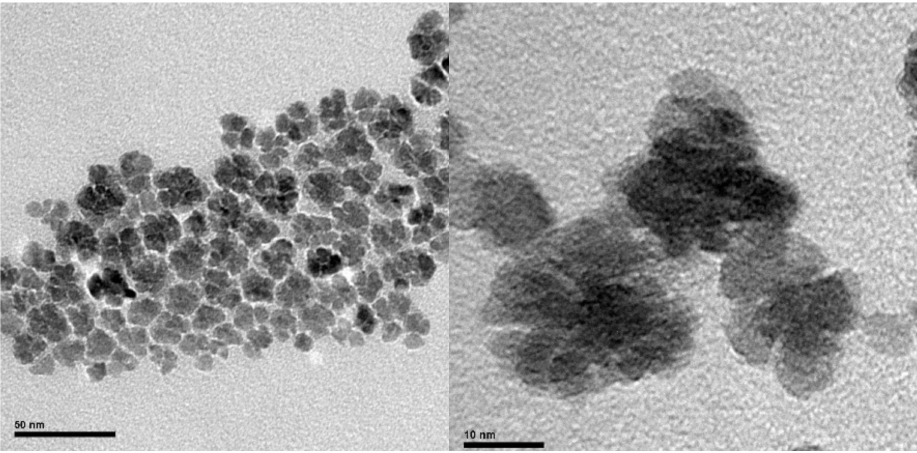
Figure 2. TEM images of IONfs at two different magnifications Scale bars are at 50 nm ( left ) nm and 10 nm ( right